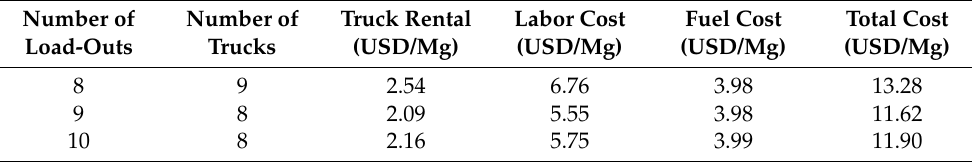
Table 8. Truck cost (USD/Mg annual delivery) for the three load-out simulations.